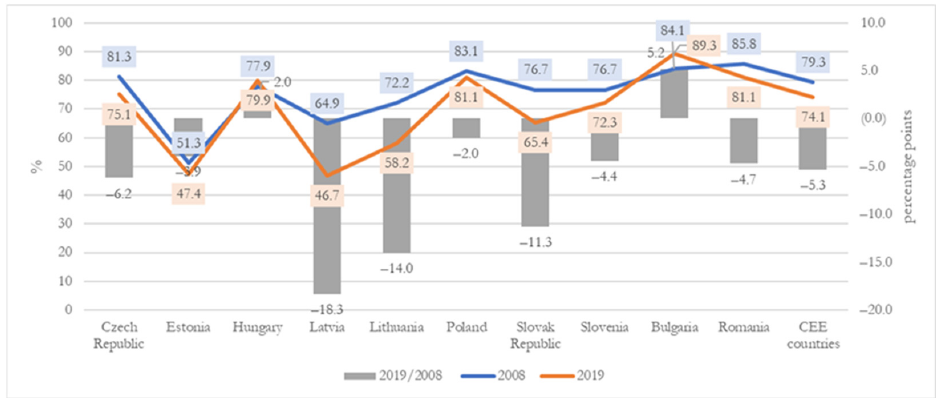
Figure 4. Share of imports of biomass for food and feed in total imports of biomass (%) (based on OECD.Stat data [36], retrieved on 15 February 2022). The analysis of exports of biomass in selected CEE countries reveals a concentration in four countries, which together represent over 62%, respectively; Poland (20.52%), Czech Republic (18.05%), Romania (13.39%), and Hungary (10.45%). In the exports of biomass for food and feed, Poland holds 23.52%, Romania almost 17%, and Czech Republic and Hungary around 14% each (Table 10 below). The dynamics from the last decade reveal a high growth of exports of biomass in Romania (by 198.4%), Bulgaria (by 161.6%), and Poland (by 116.4%). In addition, a high increase of exports of biomass for food and feed was found in Romania (by 271.2%), Bulgaria (by 183.3%), Latvia (by 133.3%), and Poland (by 129.8%). Table 10. Exports of biomass and biomass for food and feed. Total Biomass Biomass for Food and Feed Countries (Tons, Millions) (Tons, Millions) 2019/2008